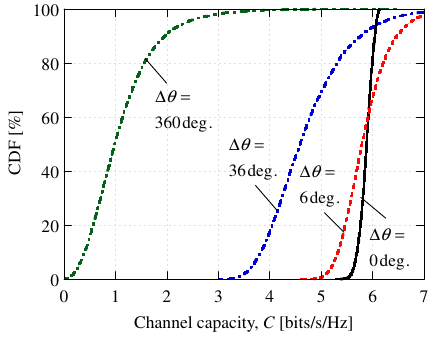
Figure 8. Cumulative density function (CDF) of C for different ∆ θ